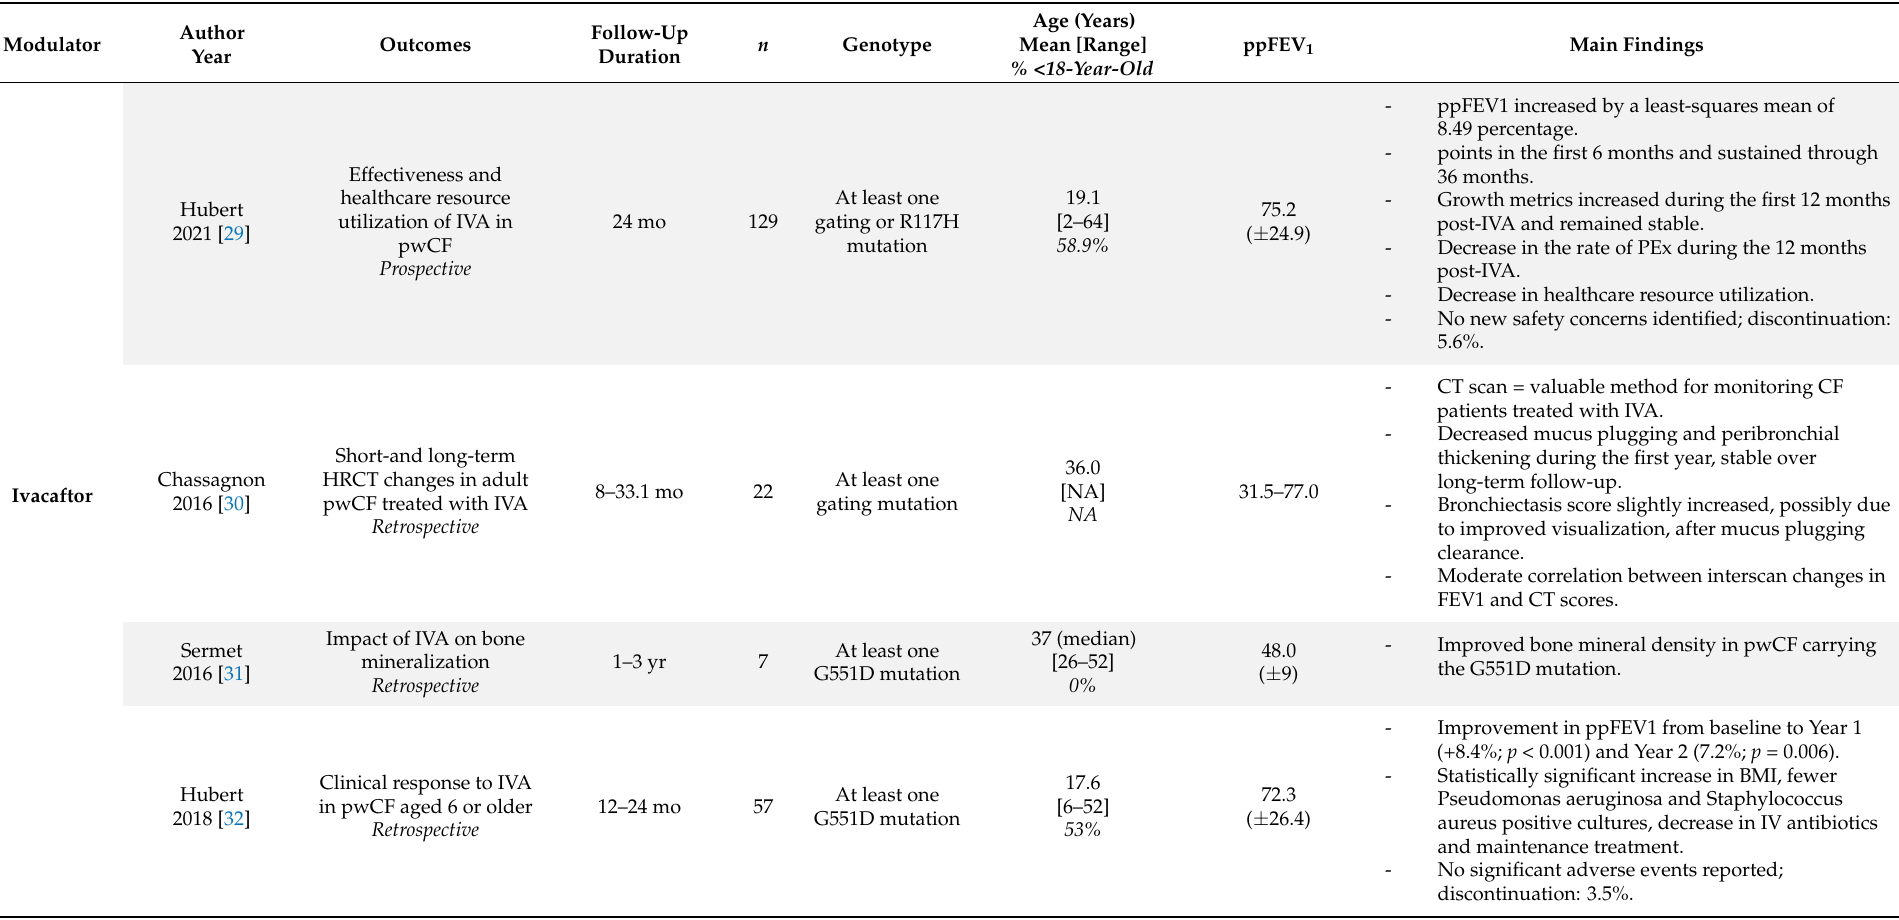
Table 3. French real-world studies on CFTR